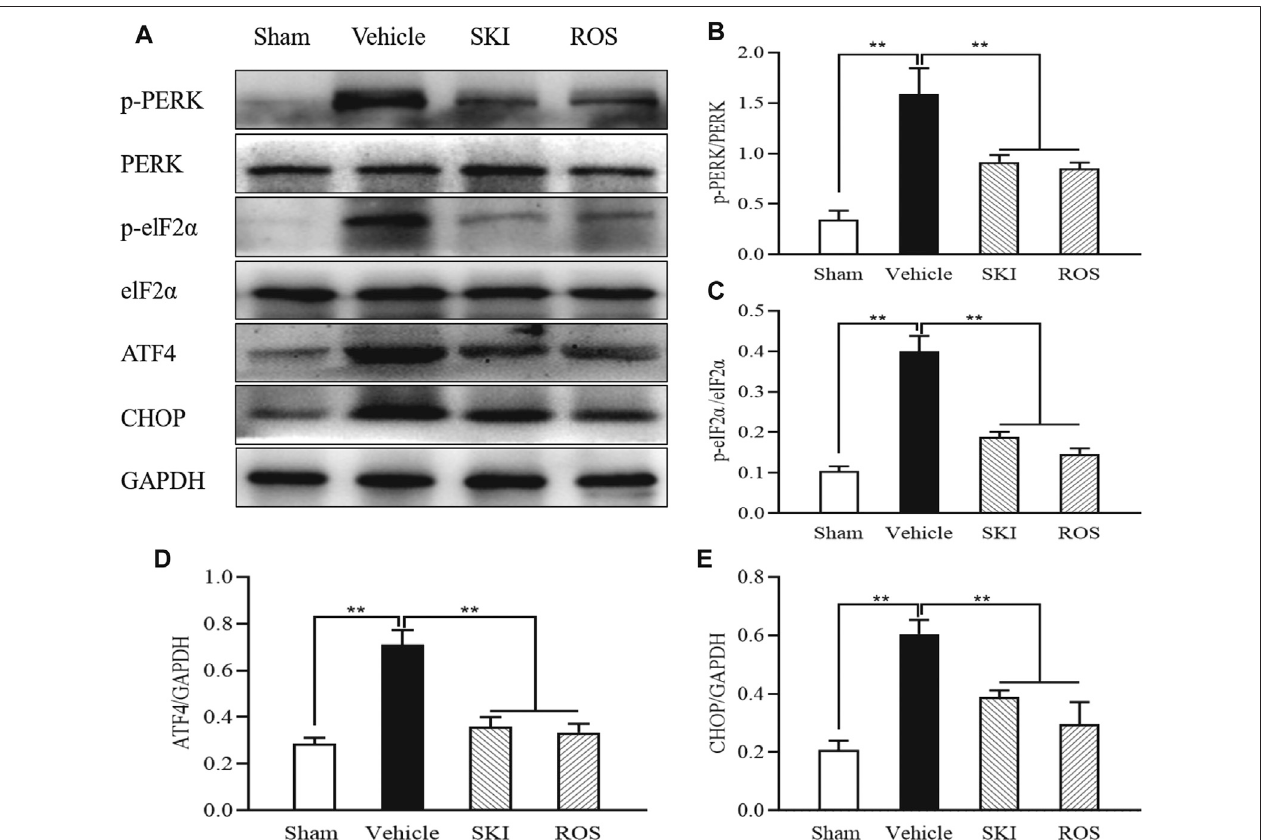
FIGURE 12 | The effects of SKI and ROS on the expression levels of key signaling molecules in the PERK-eIF2 α -ATF4-CHOP pathway in vivo . (A) WB analysis of p-PERK, PERK, p-eIF2 α , eIF2 α , ATF4, and CHOP, in the kidney; (B – E) The rate of p-PERK to PERK and p-eIF2 α to eIF2 α , and the rate of ATF4 and CHOP to GAPDH, respectively. Data are expressed as mean ± S.E. ** p < 0.01. Abbreviations: PERK, double-stranded RNA (PKR)-activated protein kinase-like eukaryotic translation initiation factor 2 α (eIF2 α ) kinase; eIF2 α , double-stranded RNA (PKR)-activated protein kinase-like eukaryotic translation initiation factor 2 α ; ATF4, activating transcription factor 4; CHOP, C/EBP homologous protein; WB, Western blot; GAPDH, glyceraldehyde-3-phosphate dehydrogenase; ROS, rosiglitazone; SKI, Shenkang